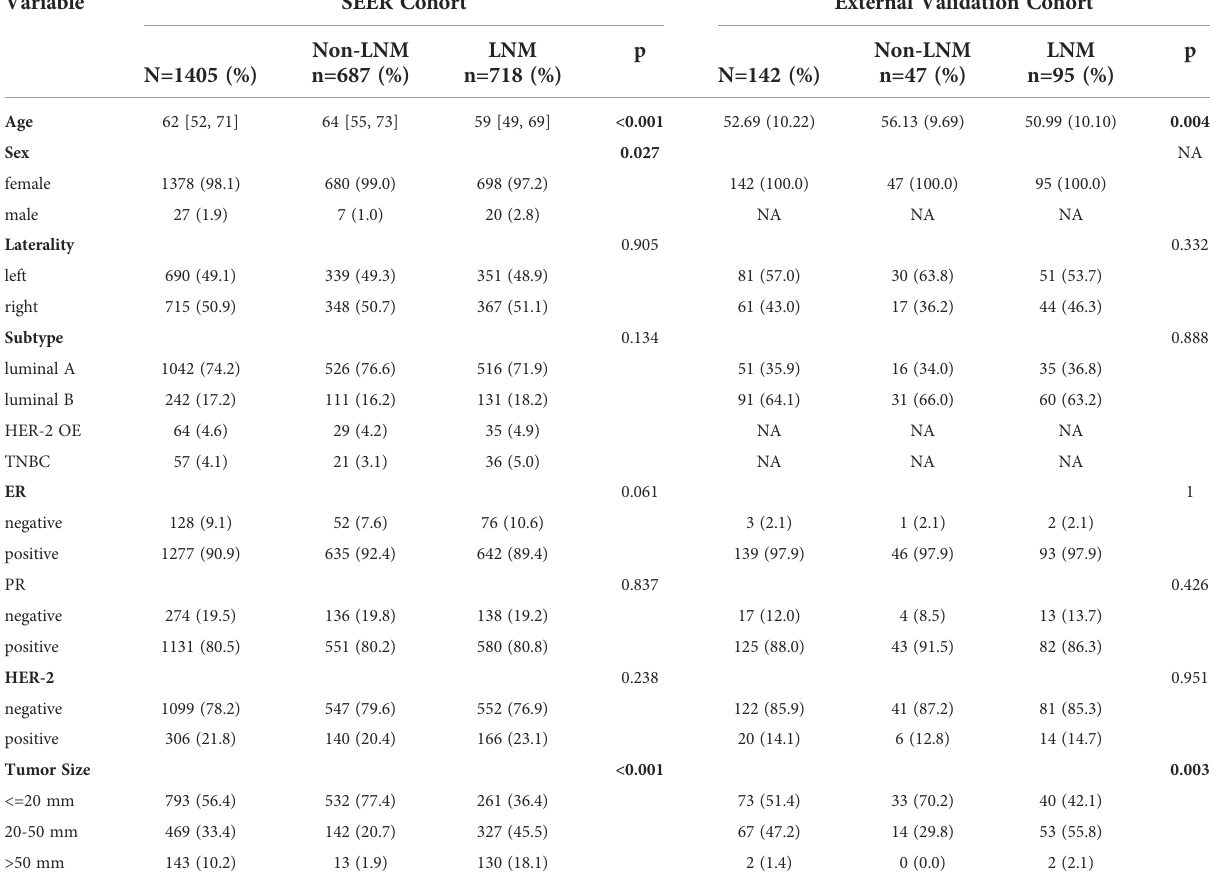
TABLE 1 Clinical and pathological characteristics of different